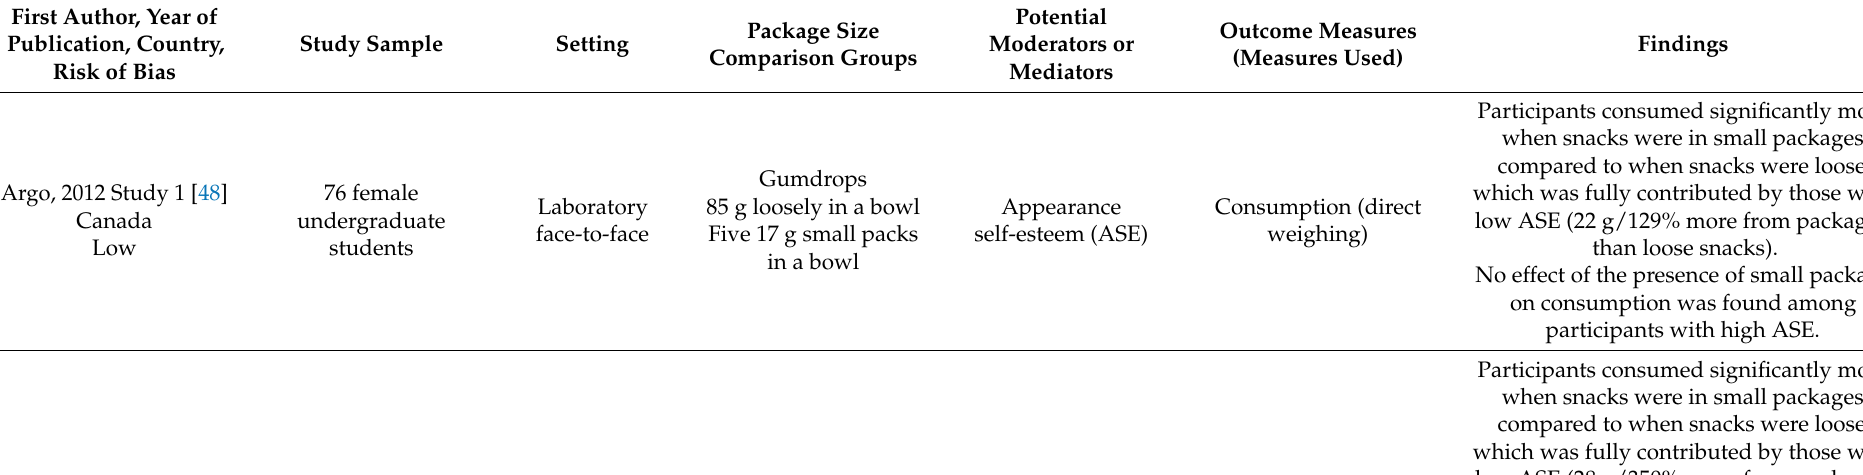
Table 4. Summary of intervention studies comparing packaged versus unpackaged energy-dense, nutrient-poor snack containing same total serving